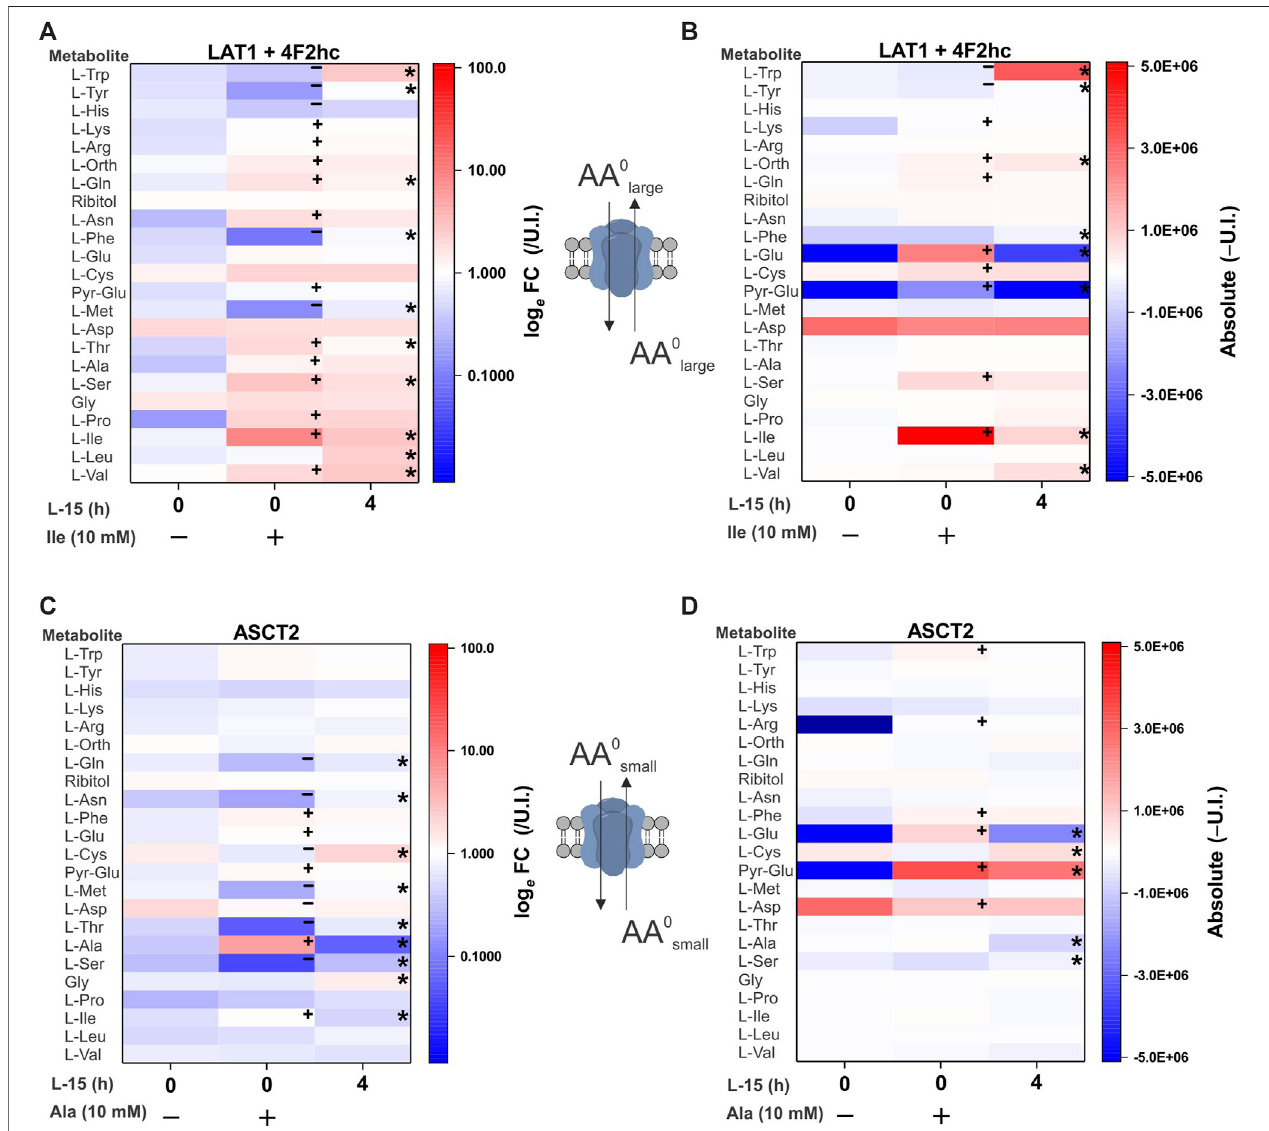
FIGURE 6 | Comprehensive amino acid fl ux pro fi le of human LAT1-4F2 and ASCT2 exchange transporters. Oocytes were injected with 5 ng each of cRNA for LAT1 and its ancillaryprotein 4F2hc or 10 ng ofASCT2 cRNA. Injected and un-injectedoocytes were maintained for 4 days in OR2 + (pH 7.8). In theexperiment oocytes were fi rst incubated for 6 h with 10 mM isoleucine (A,B) or 10 mM alanine (C,D) . Subsequently, oocytes were washed and incubated in modi fi ed L-15 medium for 4 h. After each step batches of oocytes were extracted and processed for analysis. Amino acid accumulation was analyzed as fold-change relative to un-injected (U.I.) oocytes (A,C) orasabsolute( Δ )changefrom U.I. oocytes (B,D) .The knownspeci fi cityand stoichiometryofthetransporters areshown ascartoons.Amore intensered for the same amino acid between columns indicates active accumulation, a blue change depletion. Pyro-glutamic acid (2-oxo-proline) and ornithine are included in all heat maps as they are known GC-MS derivatives of glutamate and arginine, respectively. The internal standard ribitol was also included in each heat-map as a negative controltoindicateanydeviationfromfold-changeof1 ± 0.1or10%oftheabsolutevalue.*Indicatesadifferenceinthemeansbetweenthetwotimepointsatthe p < 0.05 level using a paired t -test as calculated from the absolute mass spectrometer raw values. A + or – sign indicates an increase or decrease of a metabolite during the incubation step. The fi gures are a representative example of 3 experiments with n (cid:2) 12 transporter-expressing and 12 un-injected oocytes per